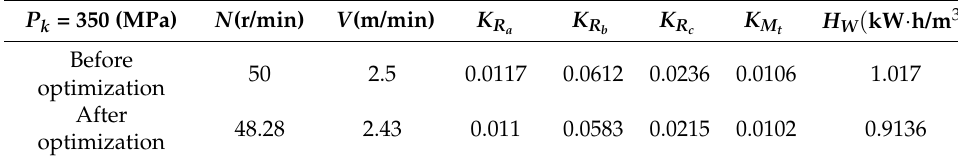
Table 4. Comparison of optimization results for P k = 350.